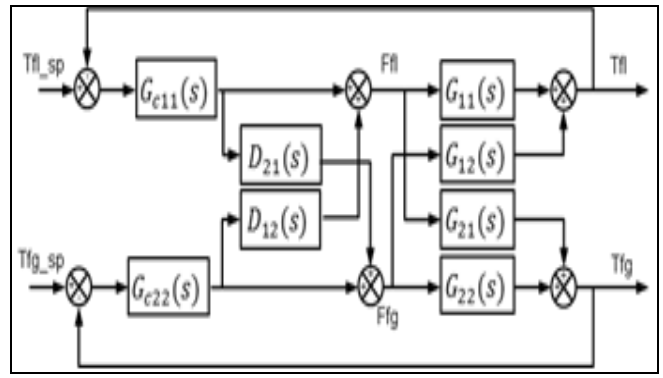
Figura 5: Diagrama en bloque del sistema de control para el Intercambiador de